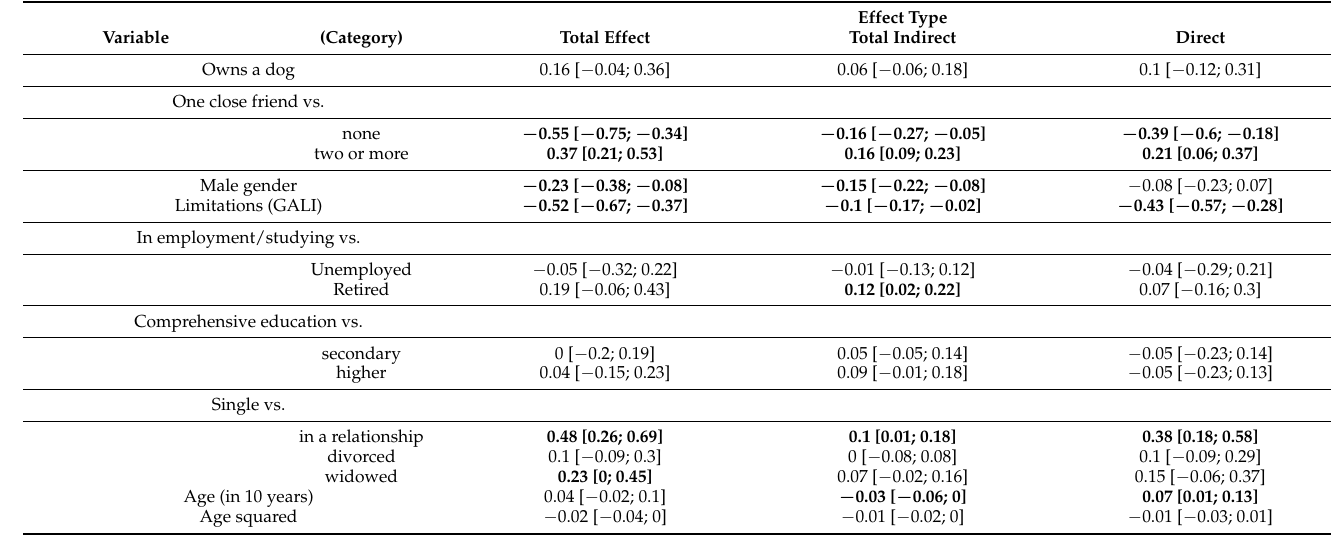
Table A2. Total, total indirect, and direct standardised effects [95% CIs] of all circumstantial factors on PMH in the main model ( n =